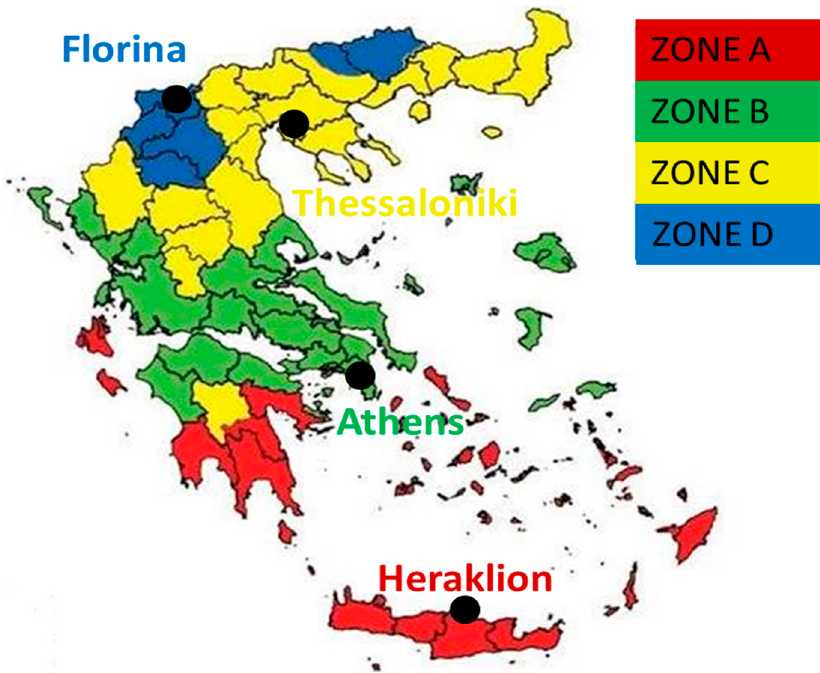
Figure 1. The Greek climate zones and the examined cities in this work [32].